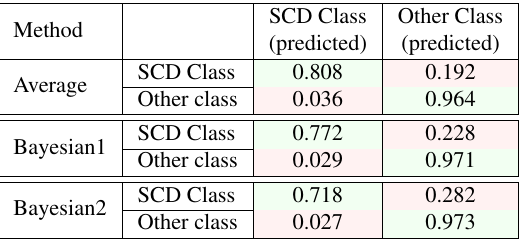
Table 6. Comparison between Averaging and Bayesian Fusion. All methods use 50% overlap. Note that Bayesian1 corresponds to the prior probabilities set to 0.2 and 0.8 respectively, while Bayesian2 corresponds to 0.1 and 0.9 (in this last case we have accuracy=0.960 and F1-score=0.639).